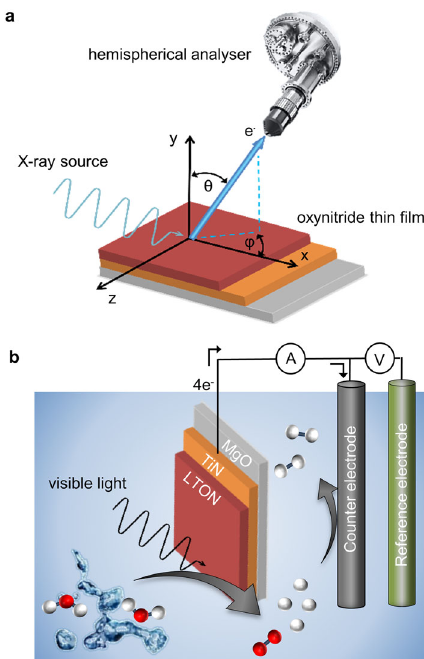
Fig. 1 Experimental overview. a Schematic of an ARPES experiment showing the photoemission geometry. b three-electrode con fi guration for the PEC characterisation. The red and white spheres represent oxygen and hydrogen,